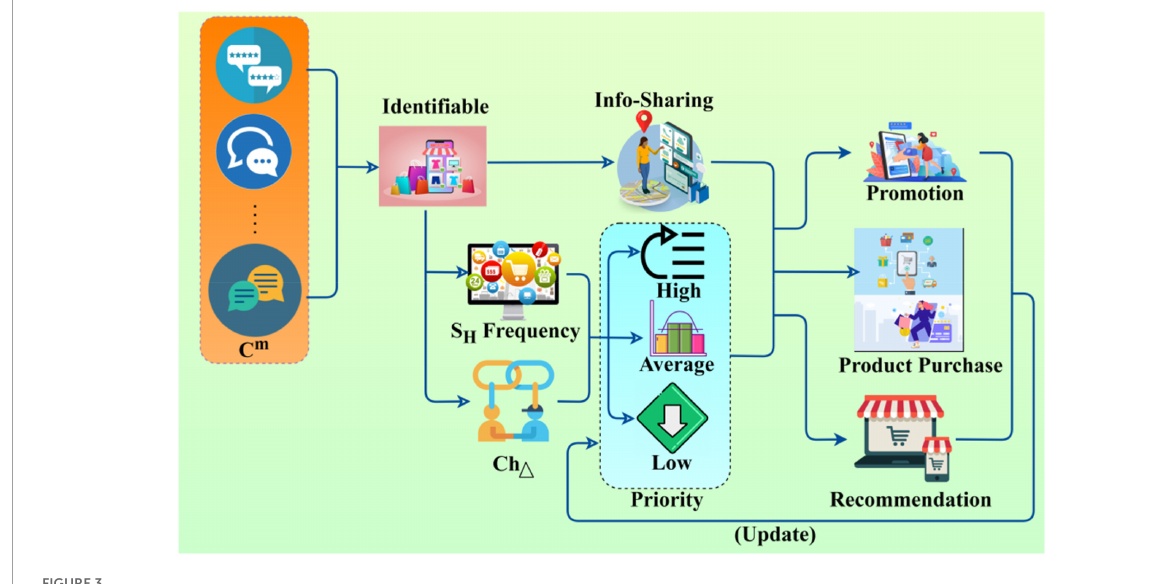
FIGURE3 Prioritization process flow.